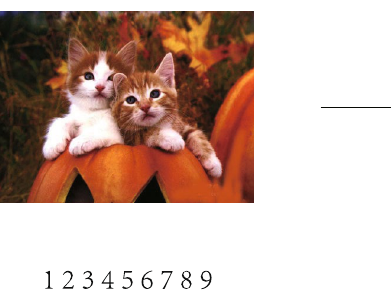
Figure 1. Emotional memory task